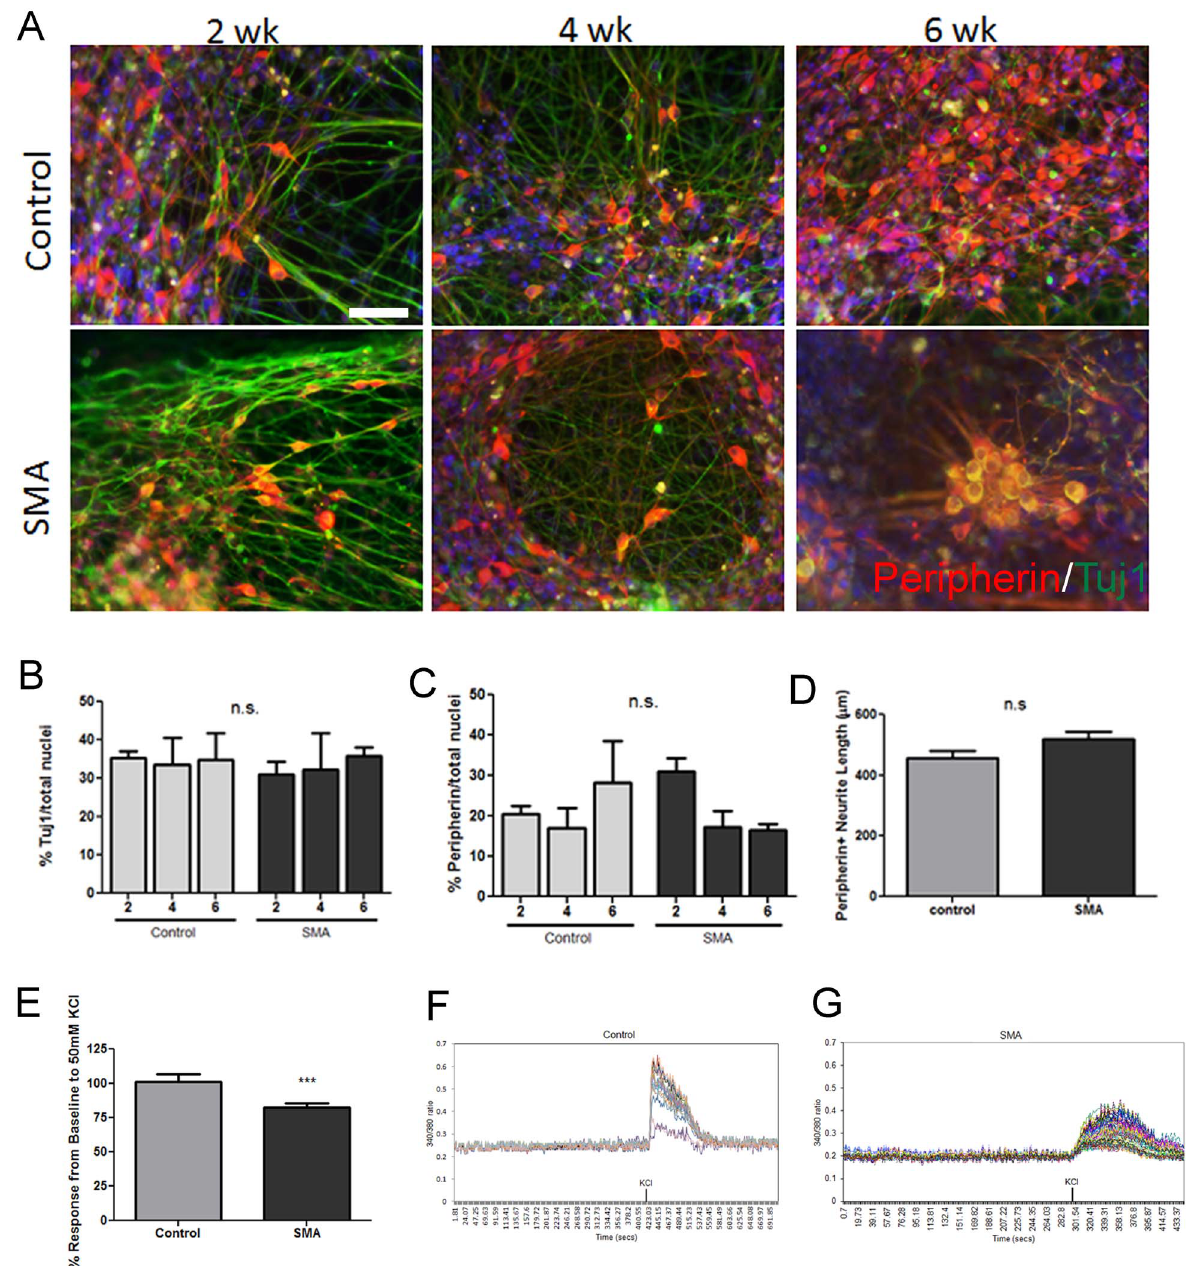
Figure 1. Consistent generation of sensory neurons from control and SMA iPSCs. (A) Control and SMA iPSCs acquire a Tuj1 + (green)/ peripherin + (red) sensory neuron phenotype by 2 weeks of differentiation that remained consistent through 6 weeks of differentiation. Nuclei are labeled with Hoechst nuclear dye (blue). Quantification of the Tuj1 + population (B) and peripherin + population (C) show no significant difference in neuronal differentiation efficiency between control and SMA iPSCs at any time point. (D) At 6 weeks of differentiation there was no difference in neurite length between control and SMA iPSC-derived sensory neurons. (E) Ratiometric live cell calcium imaging showed a significant reduction in calcium response to KCl depolarization in the SMA iPSC-derived sensory neurons at 2 weeks of differentiation compared to controls. Representative imaging traces of at least 30 individual cells are shown for (F) one control iPSC line and (G) one SMA iPSC line. KCl indicates the time at which the depolarizing stimulus was added to the cultures. n.s.=not significant by ANOVA (B and C) or by Student’s t-test (D). ***p=0.0008 by Student’s t-test (E). Scale bar=50 m m. doi:10.1371/journal.pone.0103112.g001 to KCl induced depolarization was found in SMA iPSC-derived (Figure 5A, B). Moreover, control motor neurons revealed no sensory neurons (Figure 1E), this does not appear to negatively statistical difference in cell survival when cultured in the presence impact motor neuron survival. The sensory neuron differentiation of either control or SMA iPSC-derived sensory neurons medium contains NGF as well as higher concentrations of GDNF and BDNF than what is typically found in the motor neuron (Figure 5C). Although a significant reduction in calcium response